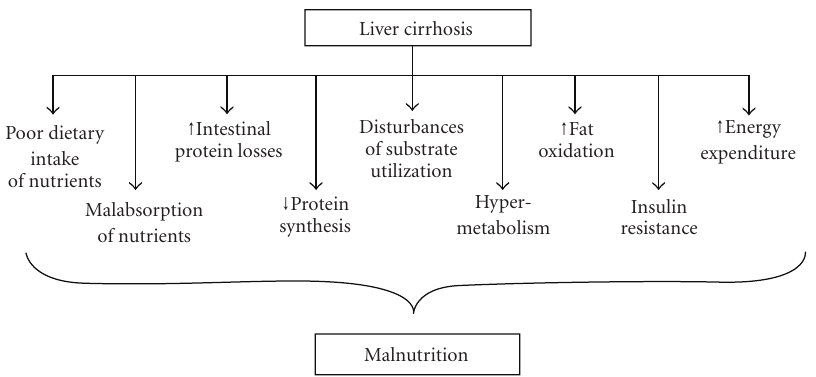
Figure 1: Factors contributing to malnutrition in end-stage liver